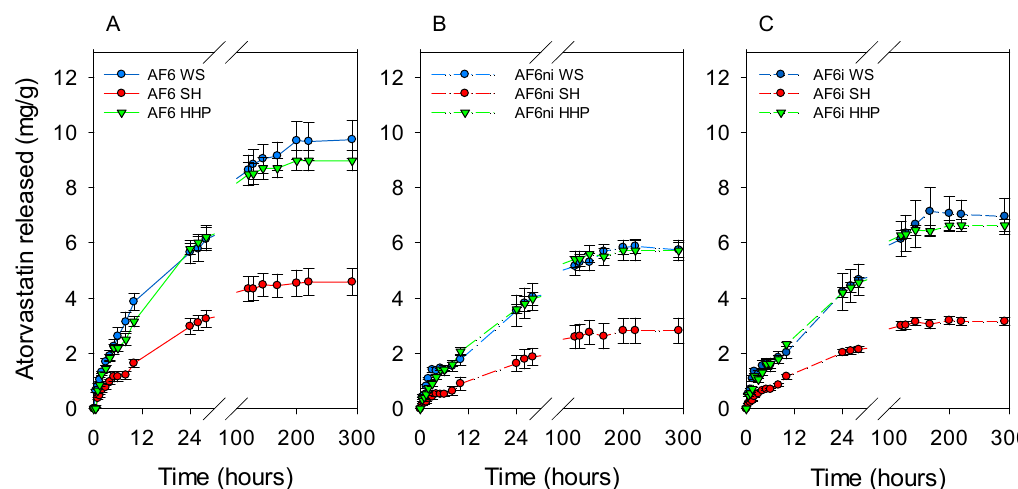
Figure 11. Comparison of atorvastatin release profiles in SLF from AF6 ( A ), AF6ni ( B ), and AF6i ( C ) hydrogels that had not been sterilized (WS) or that were sterilized during loading (immersed in drug solution) by means of steam heat (SH) or high hydrostatic pressure (HHP). Codes as in Table 1 ( n = 4; mean values and standard deviations).